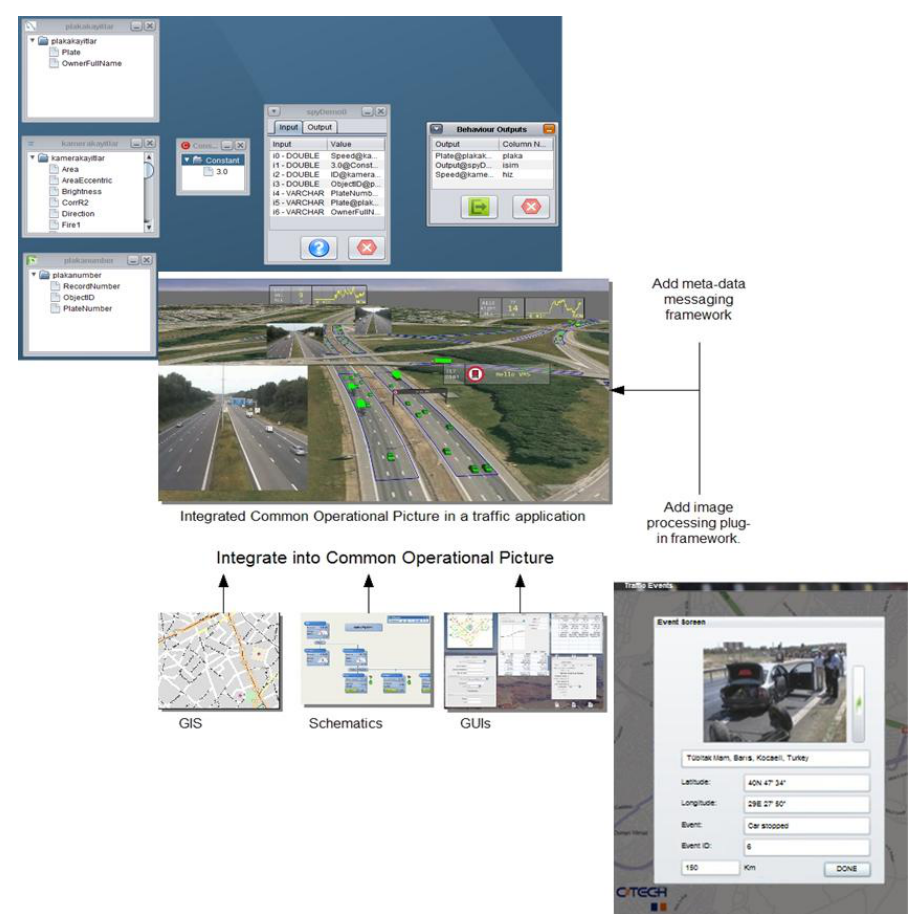
Figure 7. Fusion Engine